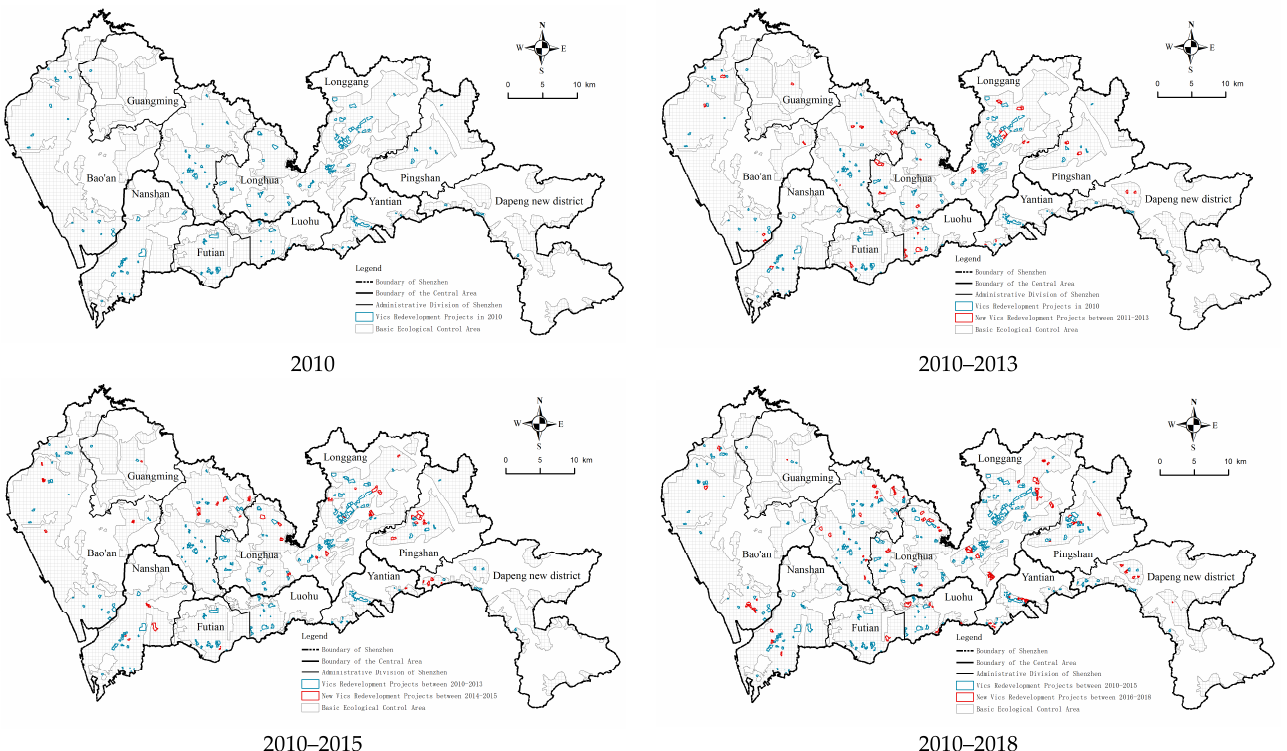
Figure 7. Annual cumulative statistically significant spatial clusters of urban village redevelopment, 2010–2018.